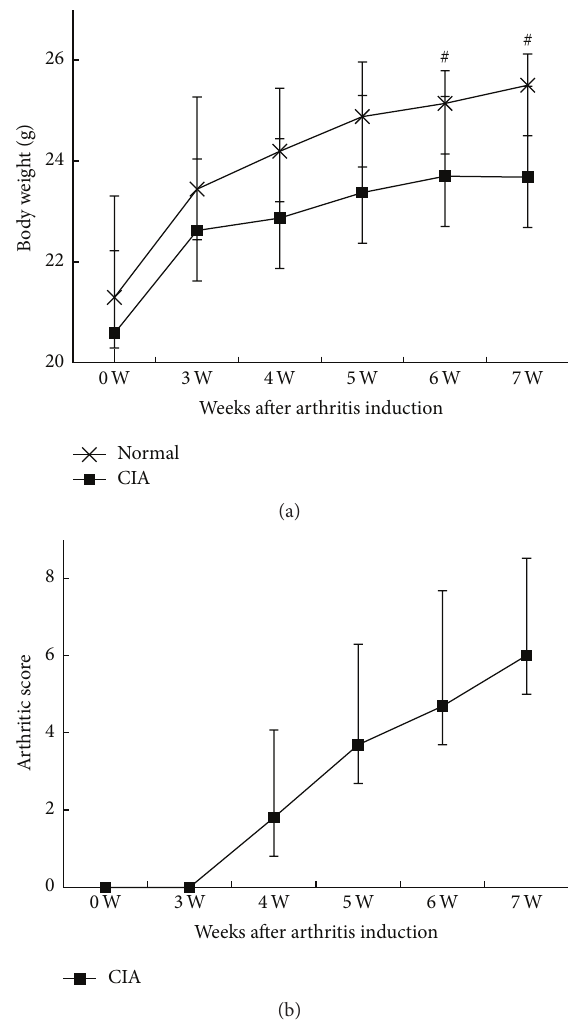
Figure 1: Clinical evaluations. (a) The changes in the body weight in the CIA group and the Normal group. The body weight in CIA group significantly reduced at 6-7 weeks after immunization, compared with the Normal group ( 𝑃 = 0.005 and 𝑃 = 0.002 , resp.). (b) The arthritis clinical scores in CIA group significantly increased at 4 weeks after immunization and peaked at 7 weeks after immunization. # 𝑃 < 0.05 , compared with Normal group.